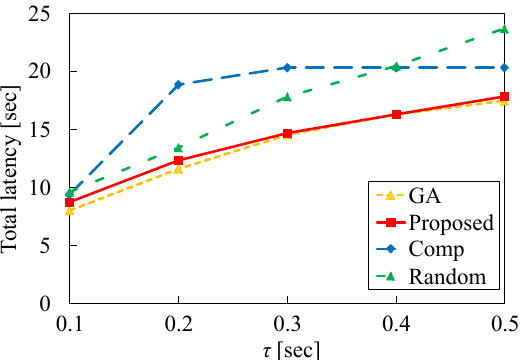
Figure 10. Total latency versus transmission delay τ in the case of N 1 = 50 and λ =